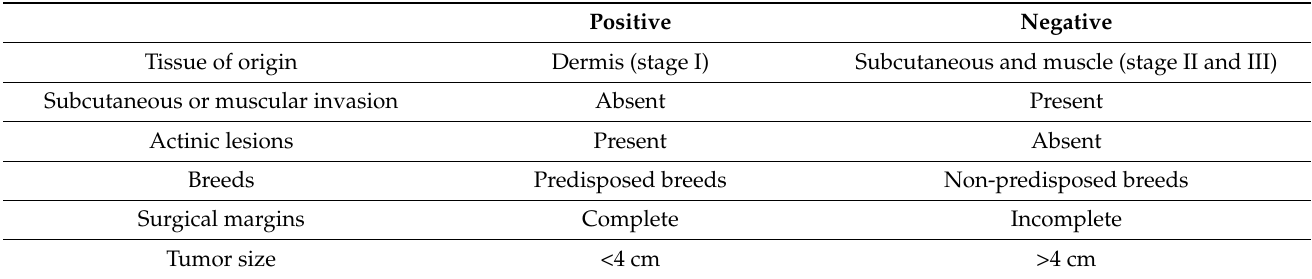
Table 3. Prognostic factors associated with non-visceral HSAs.